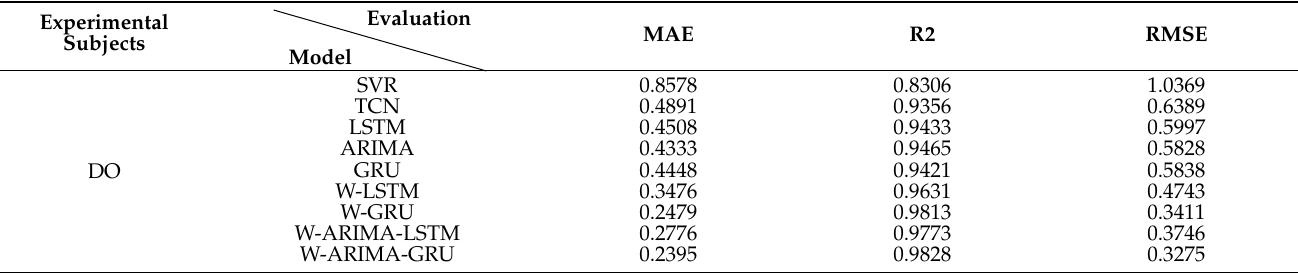
Table 5. Prediction results of each